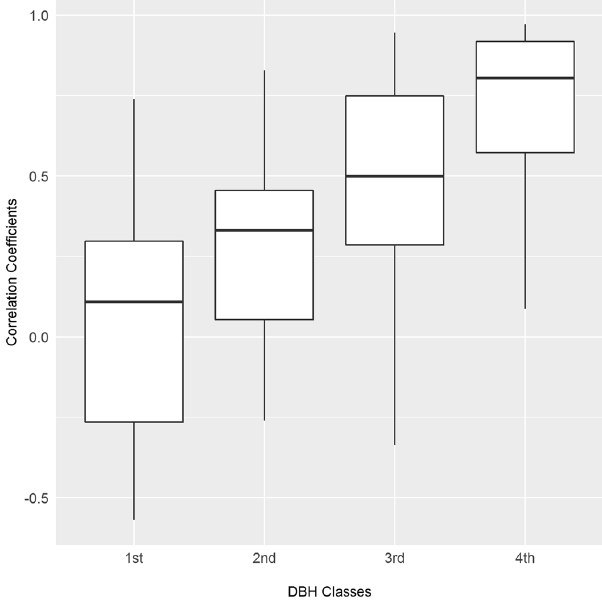
Figure 3. Correlations of RWI with tree NPP series of four DBH classes within each plot. Each box represents the variation of correlation coefficients for 36